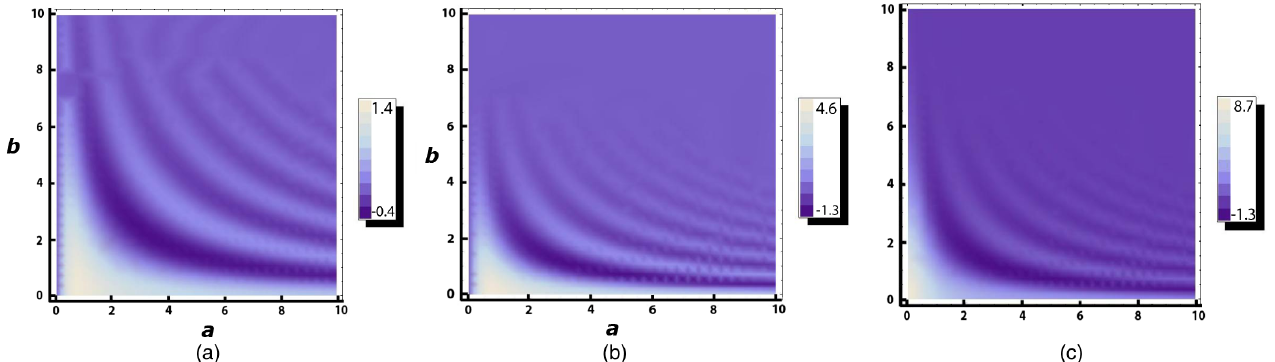
FIG. 6. Density plots of (a) − c